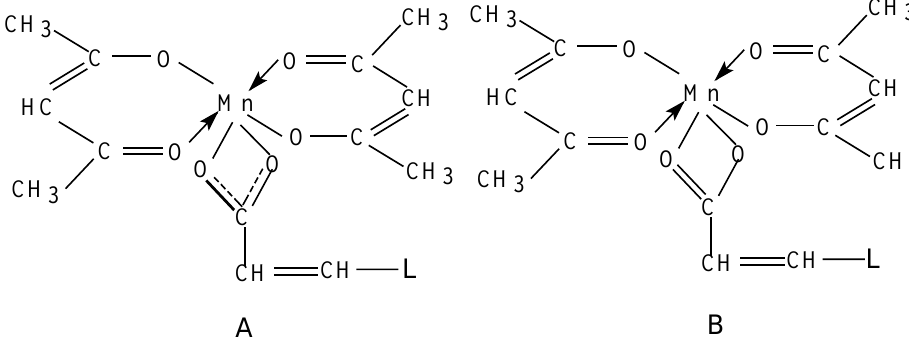
Figure 3. The proposed structure of the complexes with mixed ligands L = -COOH, Mn(III)-diacetylacetonemaleate L = -CONHOH, Mn(III) -